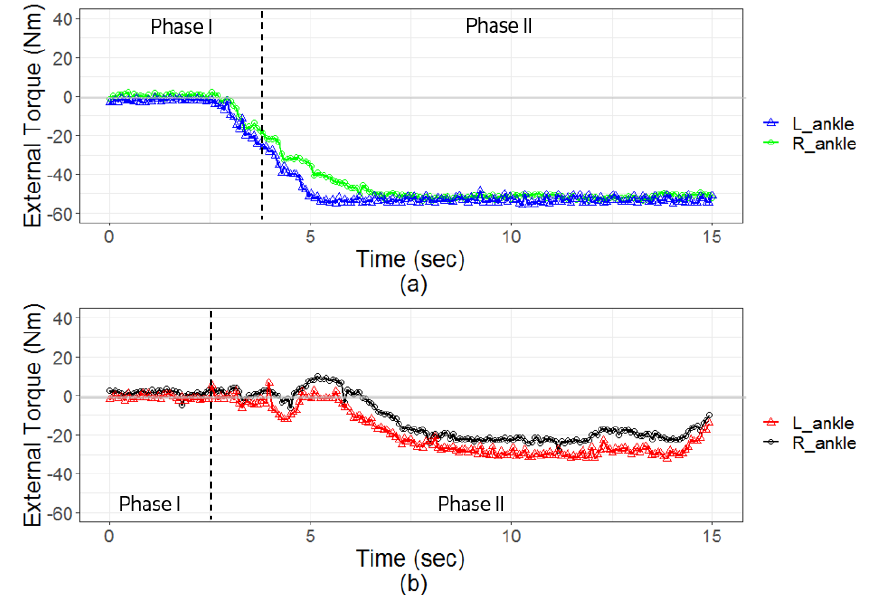
Figure 13. External torque measured from the ankle joint using the correct ( a ) and incorrect ( b ) methods of standing